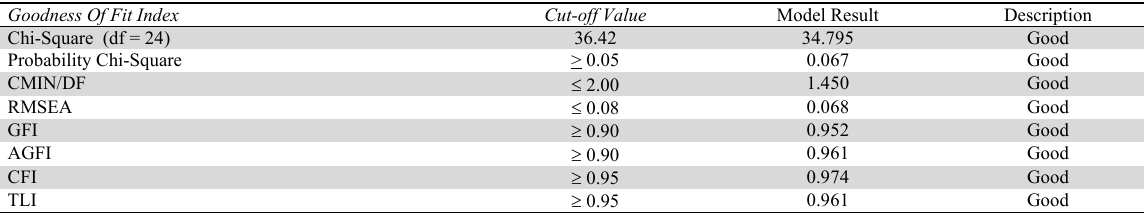
Modification of Goodness Of Fit Structural Model Test Results